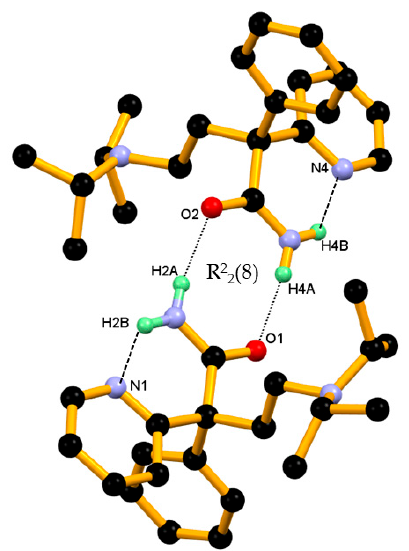
Figure 3. Two closely associated molecules of DPA, that is, molecules A and B involved in ring formation (basic dimeric unit) through an N–H ··· O hydrogen bond and the resulting R 2 2 (8) ring motifs. A second amide hydrogen N–H engaged in intramolecular hydrogen bonding with the N-atom of the 2-pyridine moiety in S 1 1 (6) motif. Dotted lines indicate the non-covalent interaction (hydrogen atoms not involved in the hydrogen bonding were removed for clarity).